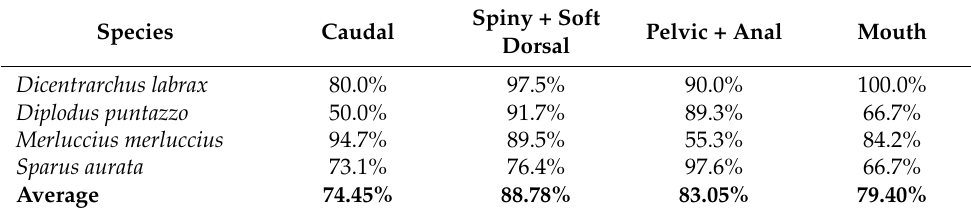
Table 6. Fish part localization for the deep learning SCIA approach described in Figure